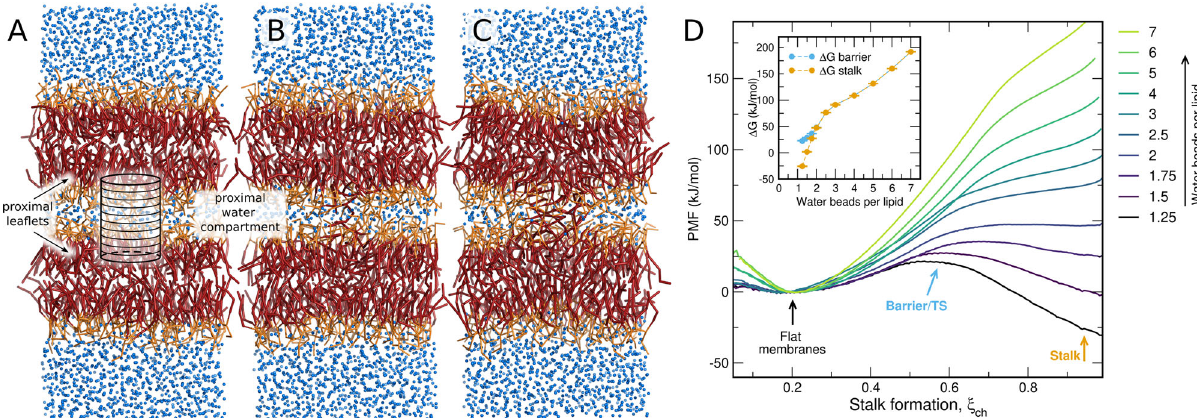
Fig. 1 Ef fi cient potential of mean force calculations of stalk formation. A – C Martini simulation system with membranes of pure POPC and 1.5 water beads per lipid in the proximal water compartment, showing representative frames of A the fl at membrane B the transition state (TS), and C the stalk. The reaction coordinate ξ ch for stalk formation quanti fi es the degree of connectivity between the two hydrophobic membrane cores, de fi ned with the help of a sliced cylinder as illustrated in A . D PMFs of stalk formation for membranes of pure POPC, with increasing hydration in the proximal compartment of 1.25 to 7 water beads per lipid, corresponding to 4 to 21.2 water beads per nm 2 (see color code). Inset: Free energy of the stalk Δ G stalk and of the stalk nucleation barrier ( Δ G barrier , if present) versus water beads per lipid in the proximal compartment, as taken from the PMFs. Error bars computed by bootstrapping denote 1 standard error (SE). Source data are provided as a Source Data fi